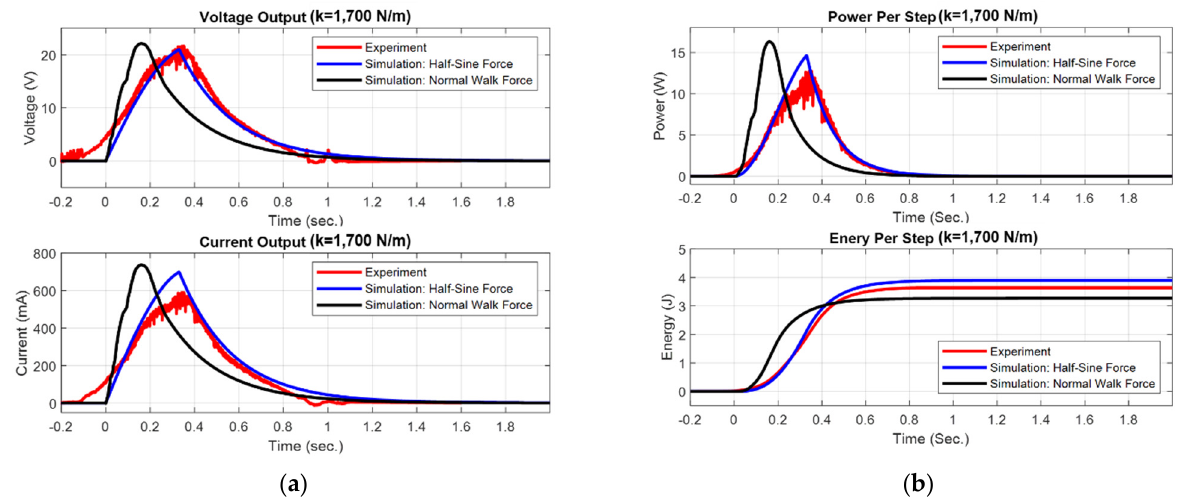
Figure 10 . The measurement of the voltage across the load resistor and the current.